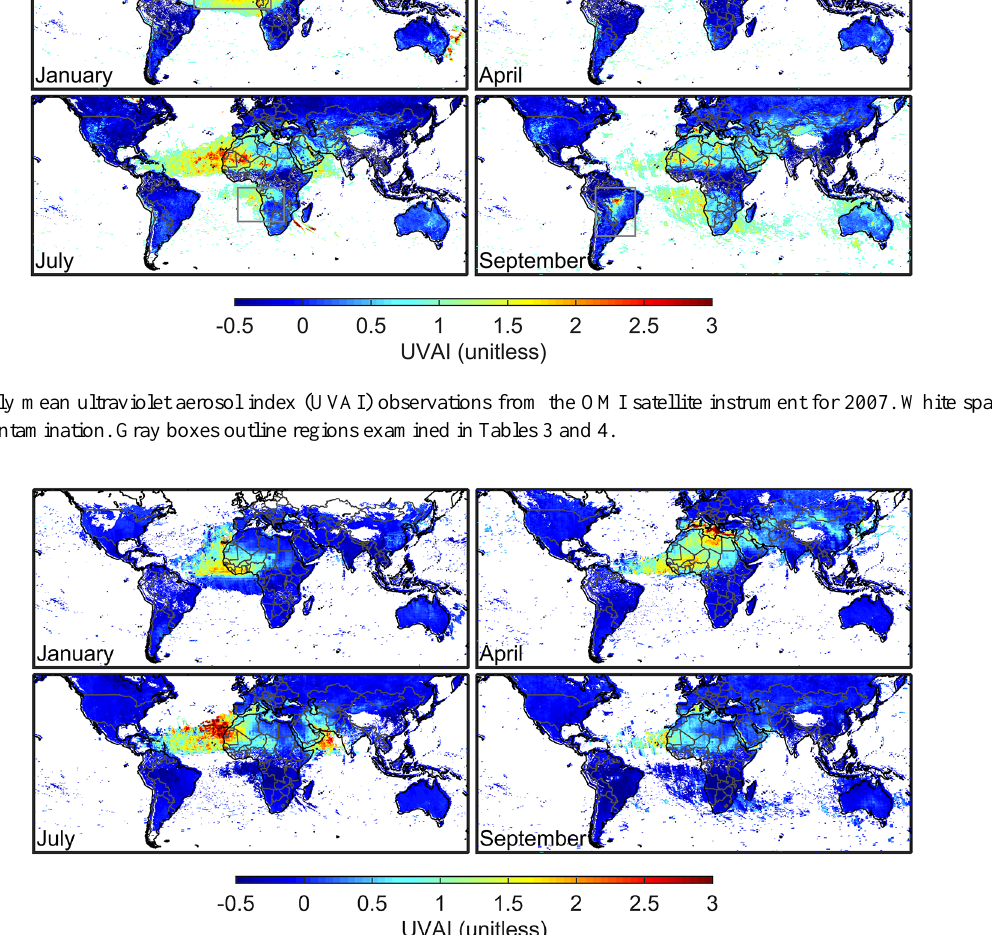
tion over West Africa yields UVAI values between 1 and